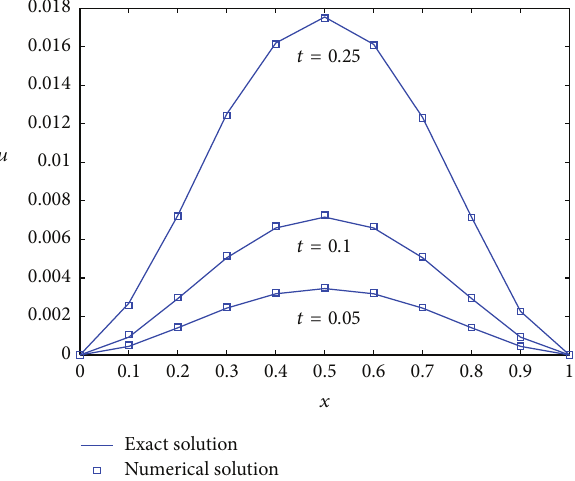
Figure 1: Numerical solution and exact solution for Example 1. Figure 2: Numerical solution and exact solution for Example 2.